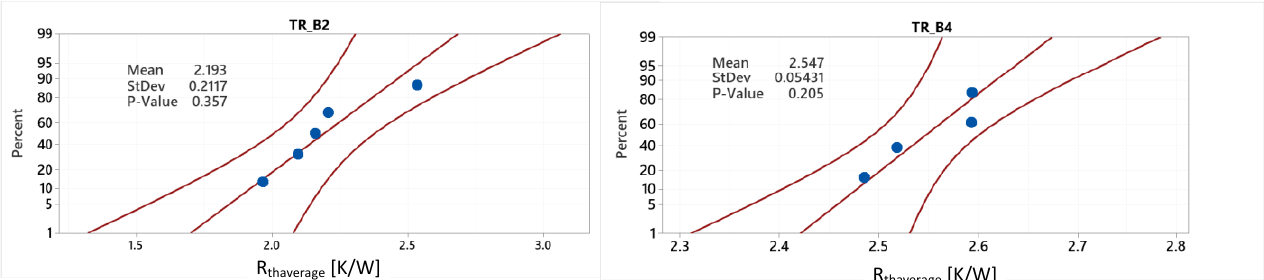
Figure 8. Probability plot, R thaverage test of normality of the TR_B transistors located in the positions 2 and 4.